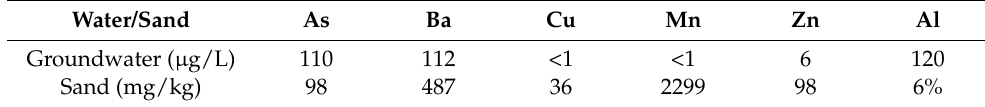
Table 1. Observed background metal concentrations in groundwater and aquifer